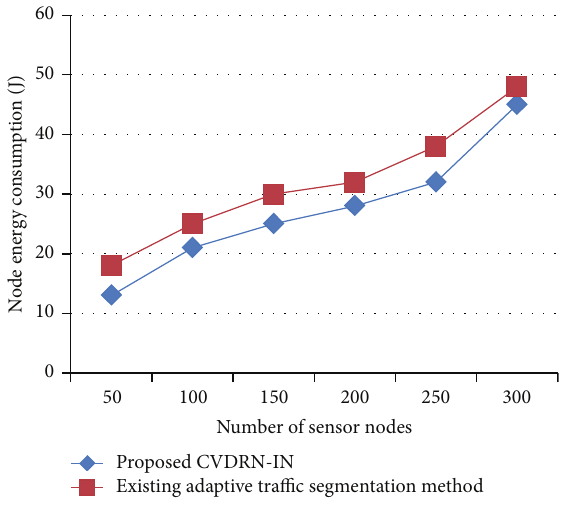
Figure 3: Measure of node energy consumption.